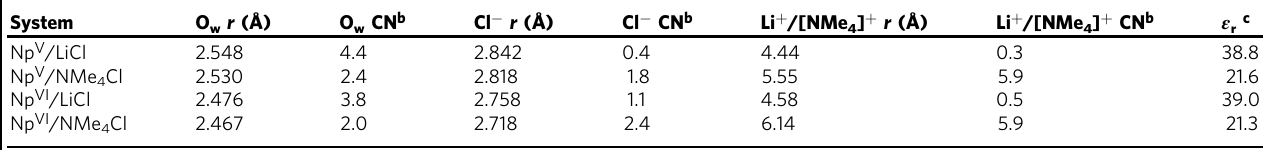
Table 1 Average coordination environment surrounding Np V O 2 + and Np VI O 2 2 + cations in LiCl or NMe 4 Cl solutions determined from all – atom MD simulations a